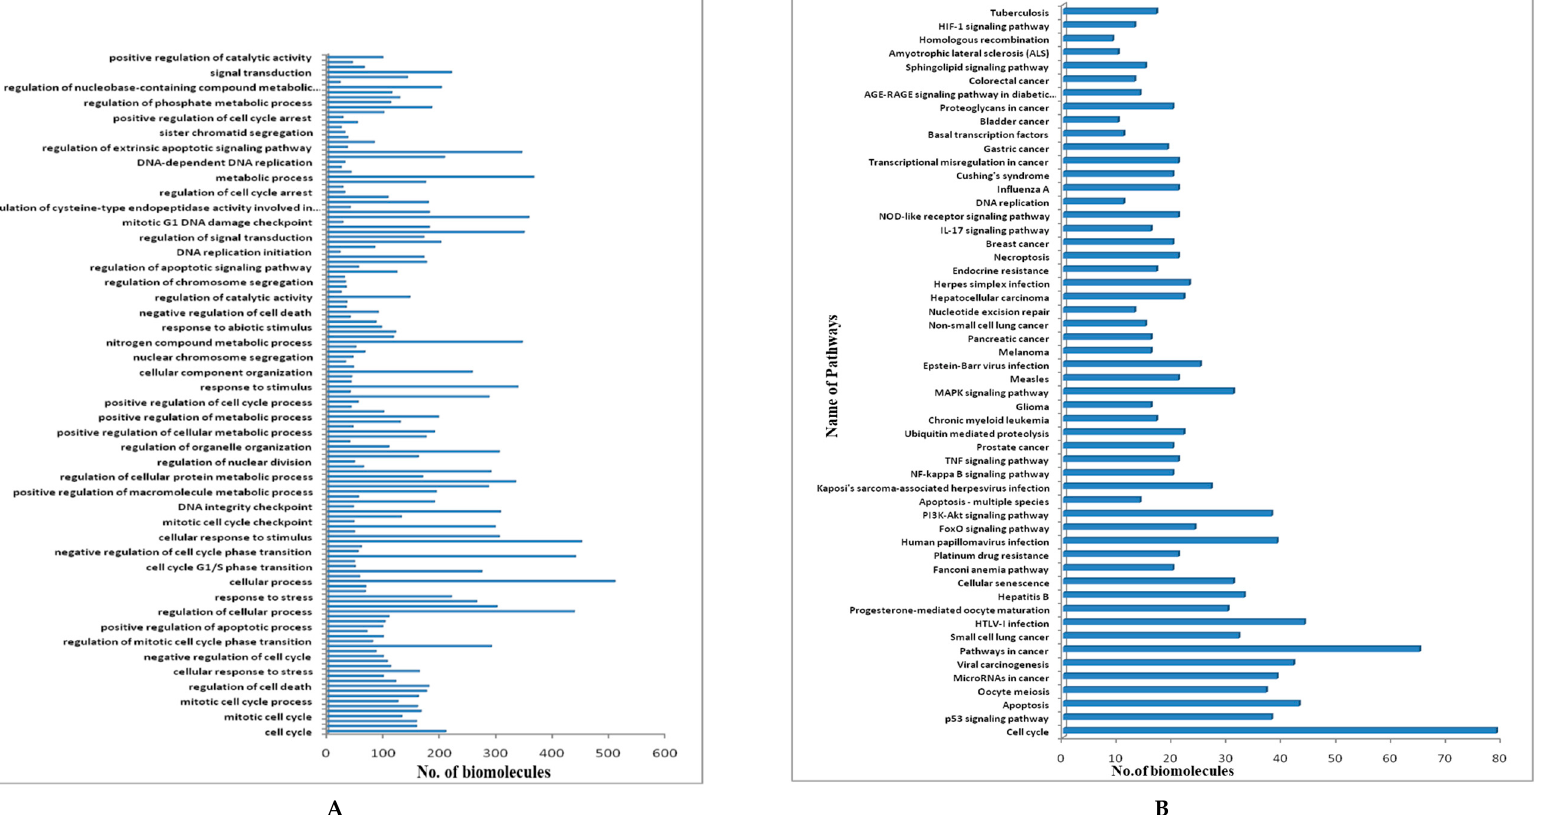
Figure 3. ( A ) Processes enriched by NNK rewired PPIN. ( B ) Pathways enriched by NNK rewired PPIN.